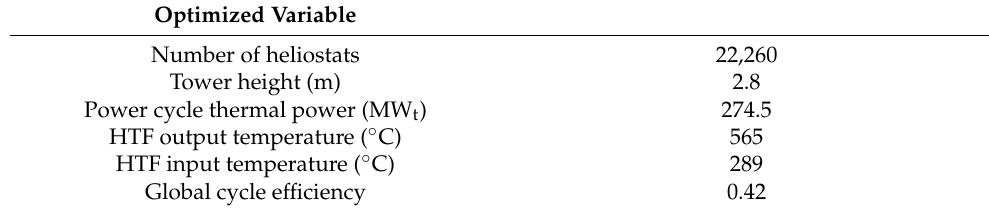
Table 4. Optimal CSP design.